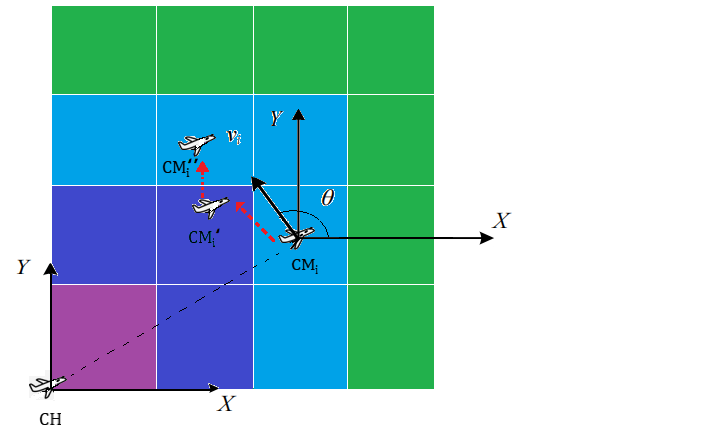
Figure 5. Prediction of cluster member movement.